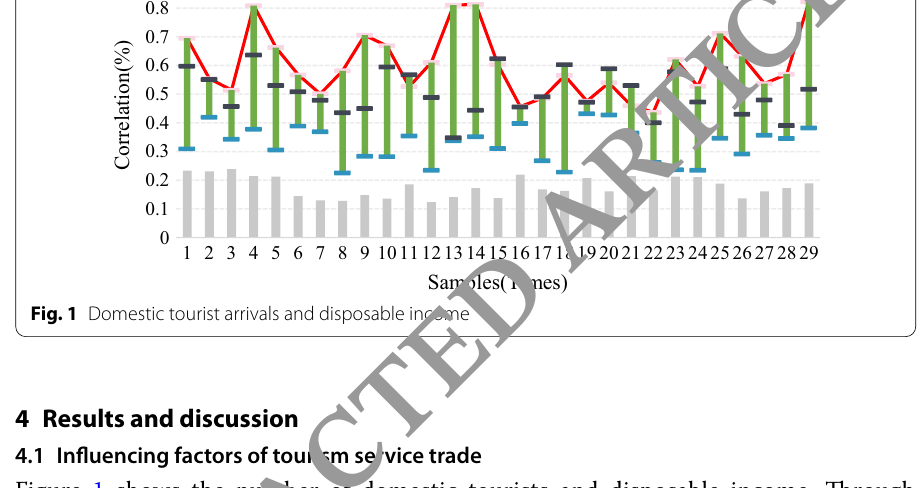
Fig. 1 Domestic tourist arrivals and disposable